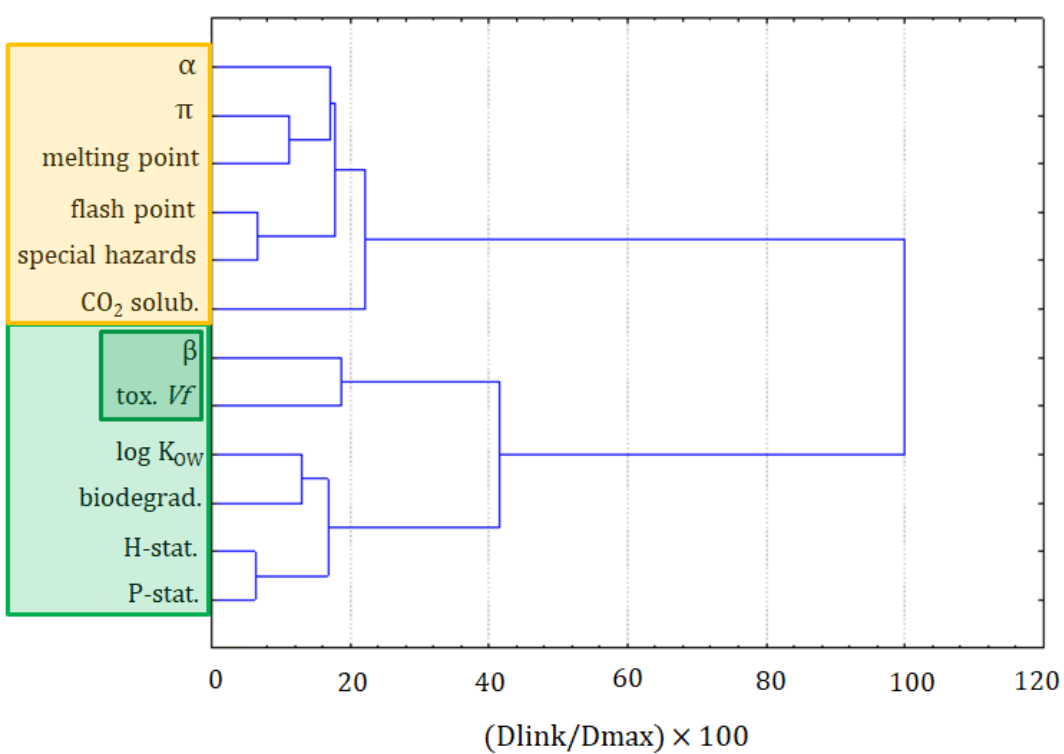
Figure 1. The hierarchical dendrogram for all 12 variables (all ionic liquids (ILs) and molecular solvents are considered).